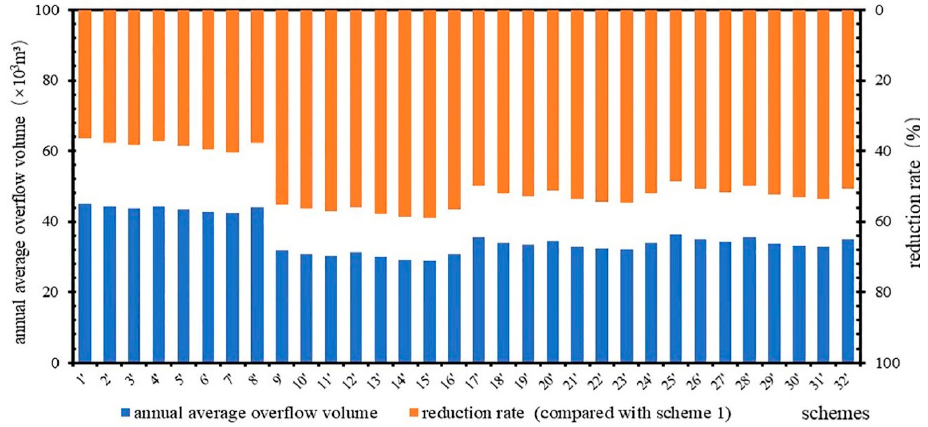
Figure 4. Annual average overflow statistics.